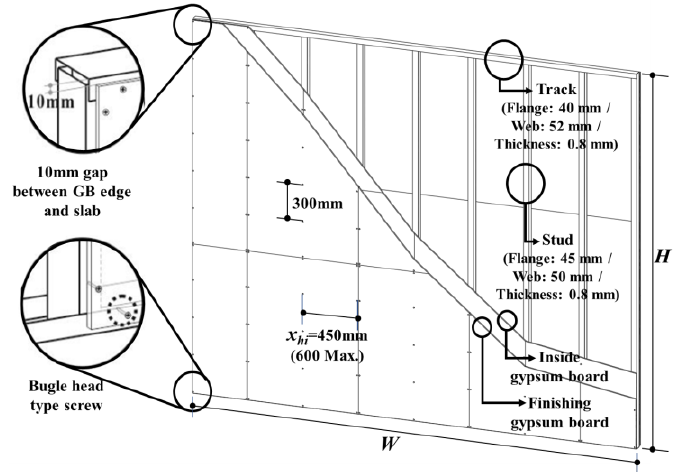
Figure 1. Elements and their dimensions of a cold-formed steel (CFS) partition wall erected by typical Korean construction practices.